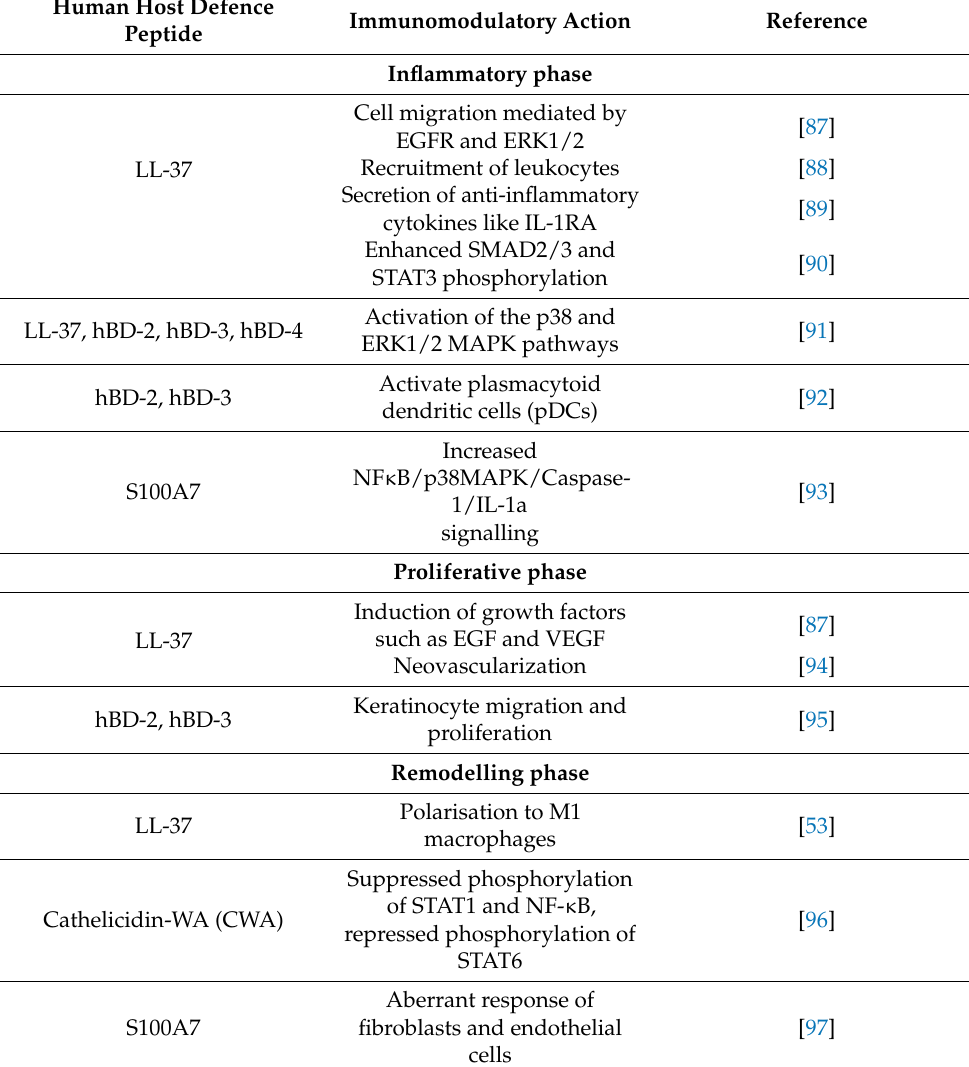
Table 1. Host defence peptides immunomodulatory actions in wound healing